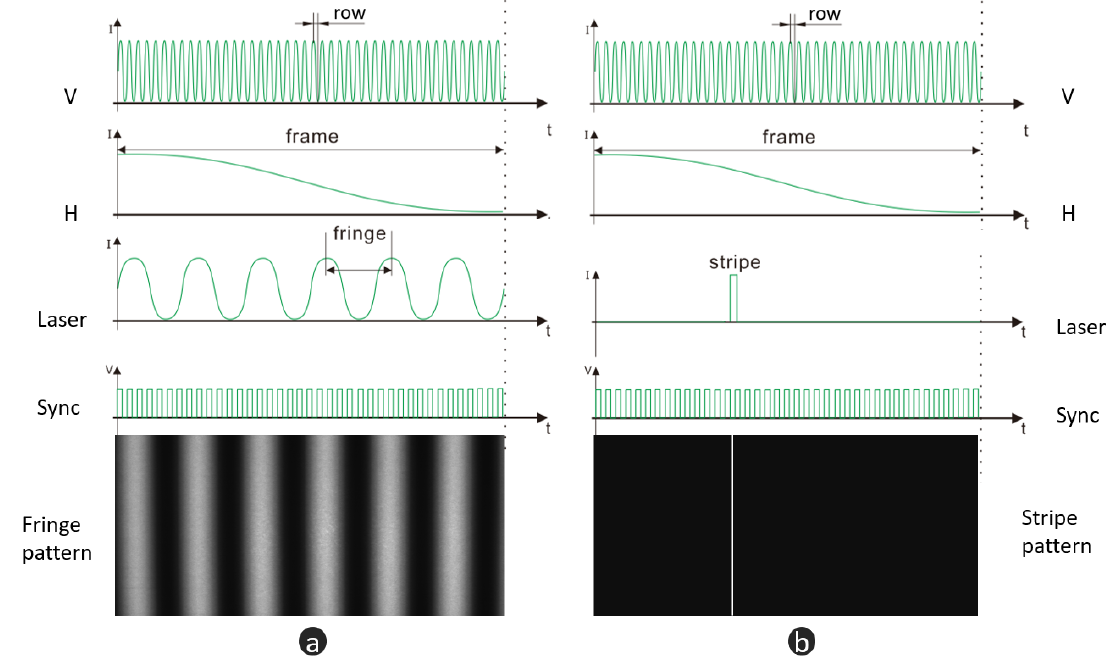
Figure 3. Controlling signals of pattern projection. ( a ) controlling signal of fringe projection; ( b ) controlling signal of stripe projection. H and V are the horizontal and vertical driven signals of the MEMS micromirror. Sync is the row sync signal. Laser is the modulation signal of the laser diode